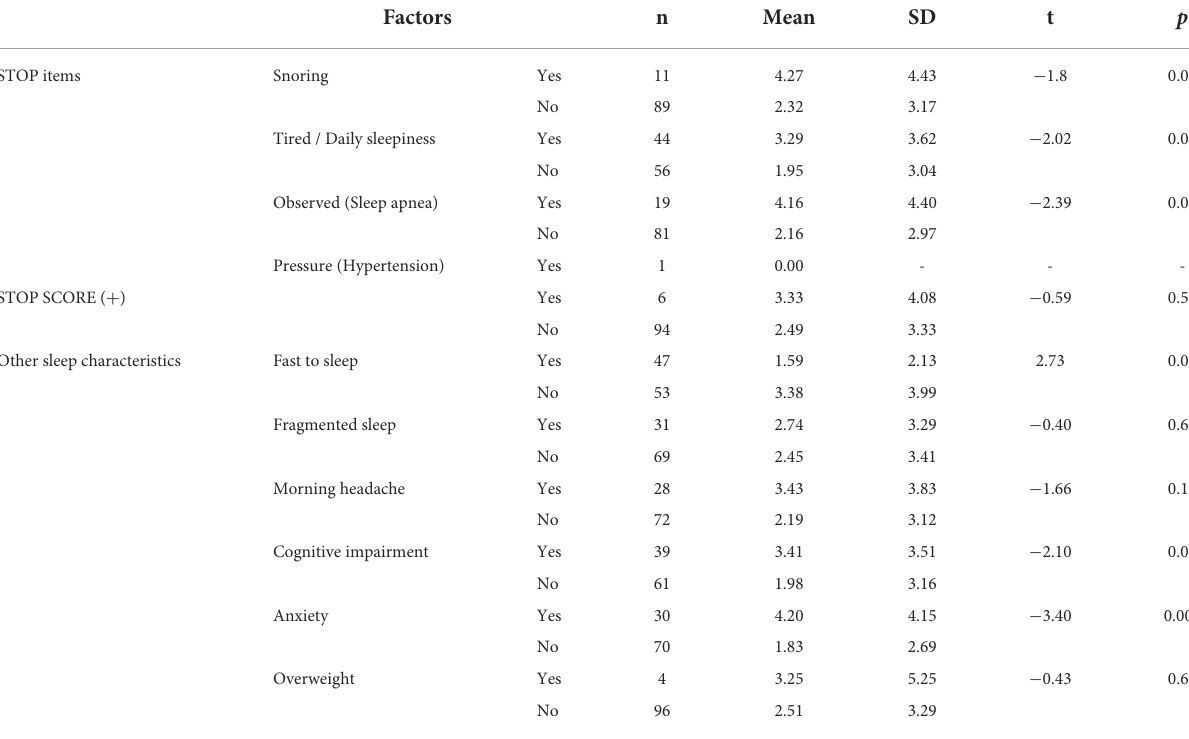
TABLE 4 Sleep characteristics and Pichot’s Depression score of study participants ( n = 100). Factors n Mean SD